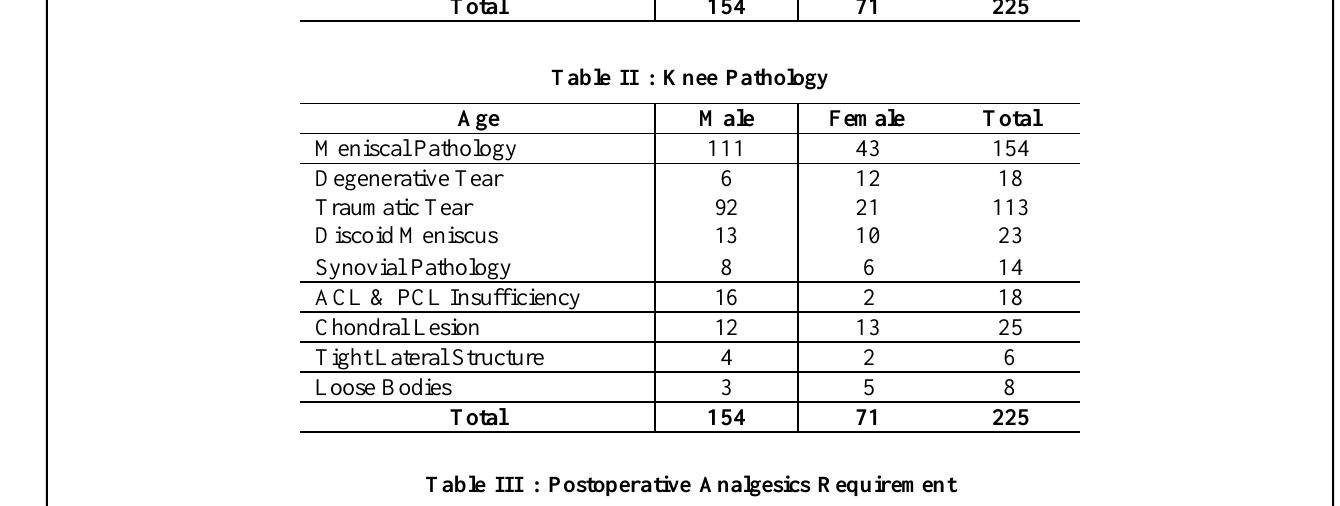
Table II : Knee Pathology